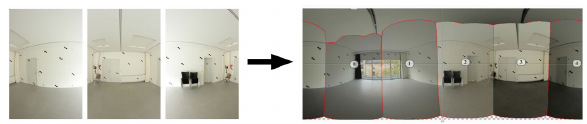
Figure 3: The stitching of Canon DSLR Images to panoramic HDRI was carried out in ptGUI Pro (a).